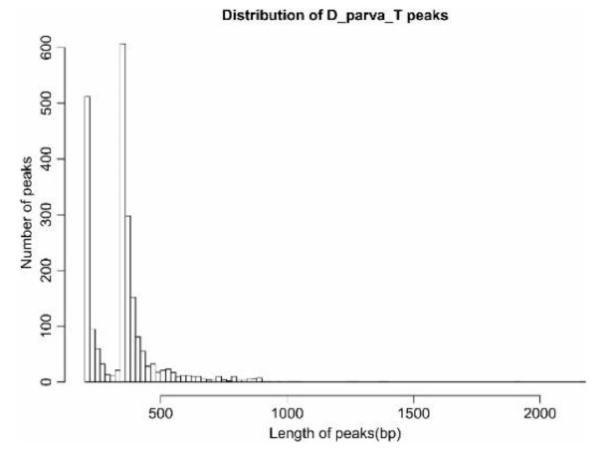
FIGURE 5 | Distribution of D_parva_T peaks.